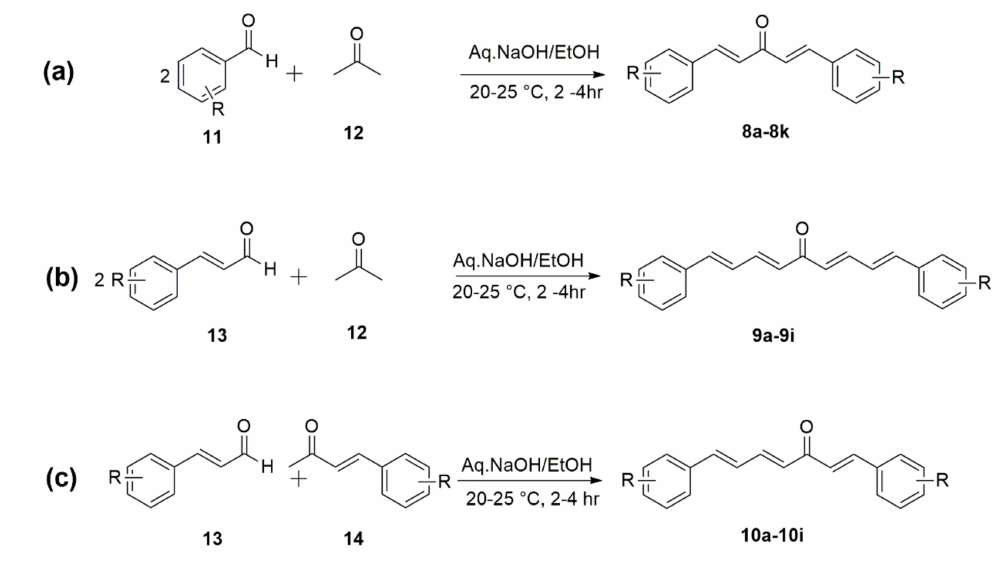
Figure 2. Synthesis of ( a ) dibenzeledeneacetone, ( b ) dicinnamalacetone, and ( c ) trienonanalogs of